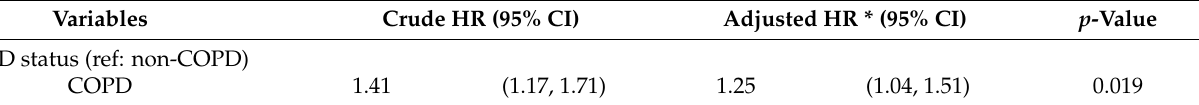
Table 2. Cox proportional hazards models of all-cause mortality for patients with rectal adenocarcinoma with or without smoking-related chronic obstructive pulmonary disease before